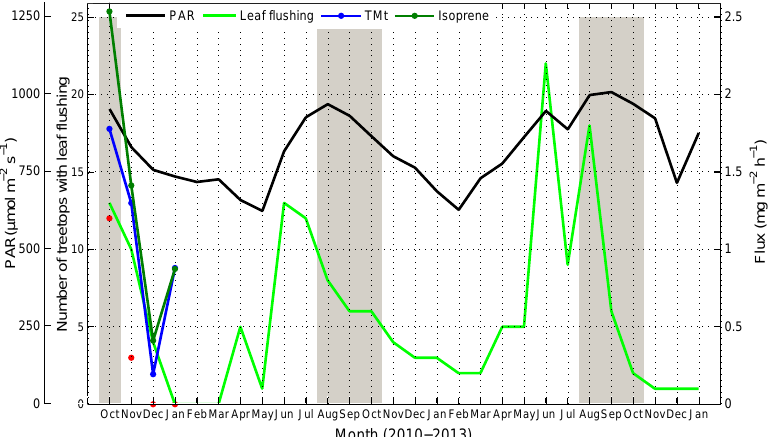
Figure 6. Estimated monthly leaf flushing (light green line) (Tavares, 2013), and monthly average of PAR measured from October 2010 to January 2013 at K34 tower (06:00–18:00, LT) (black line). For the period of this study, leaf flushing is also represented by the analysis of canopy images for every 6 days from October 2010 to January 2011 (red circles). Monthly averages of fluxes of isoprene (dark green line) and total monoterpenes (blue line) (estimated for 10:00–14:00, LT, at TT34 tower). Grey areas represent the period of the dry